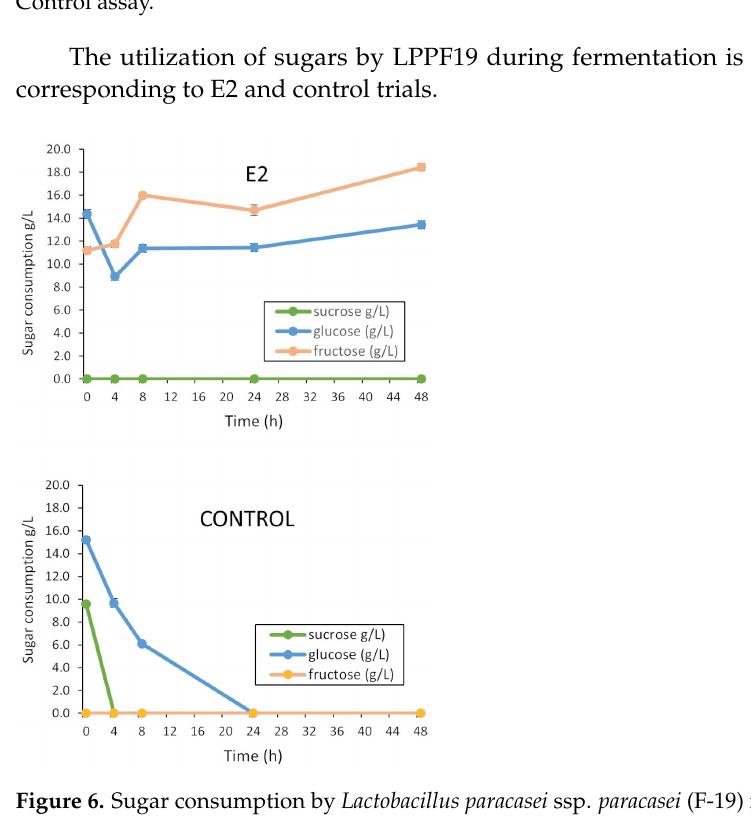
Figure 5. Growth of biomass and pH in fermentation of Lactobacillus paracasei ssp. paracasei (F-19) in Control assay.